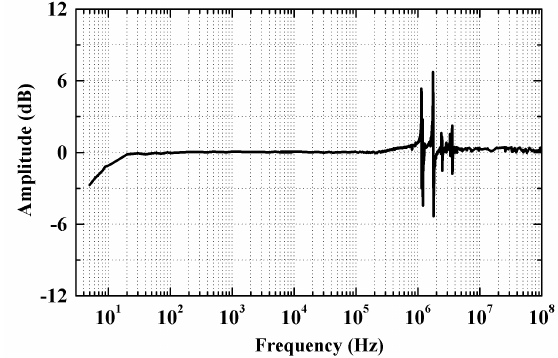
Figure 6. Amplitude-frequency response.